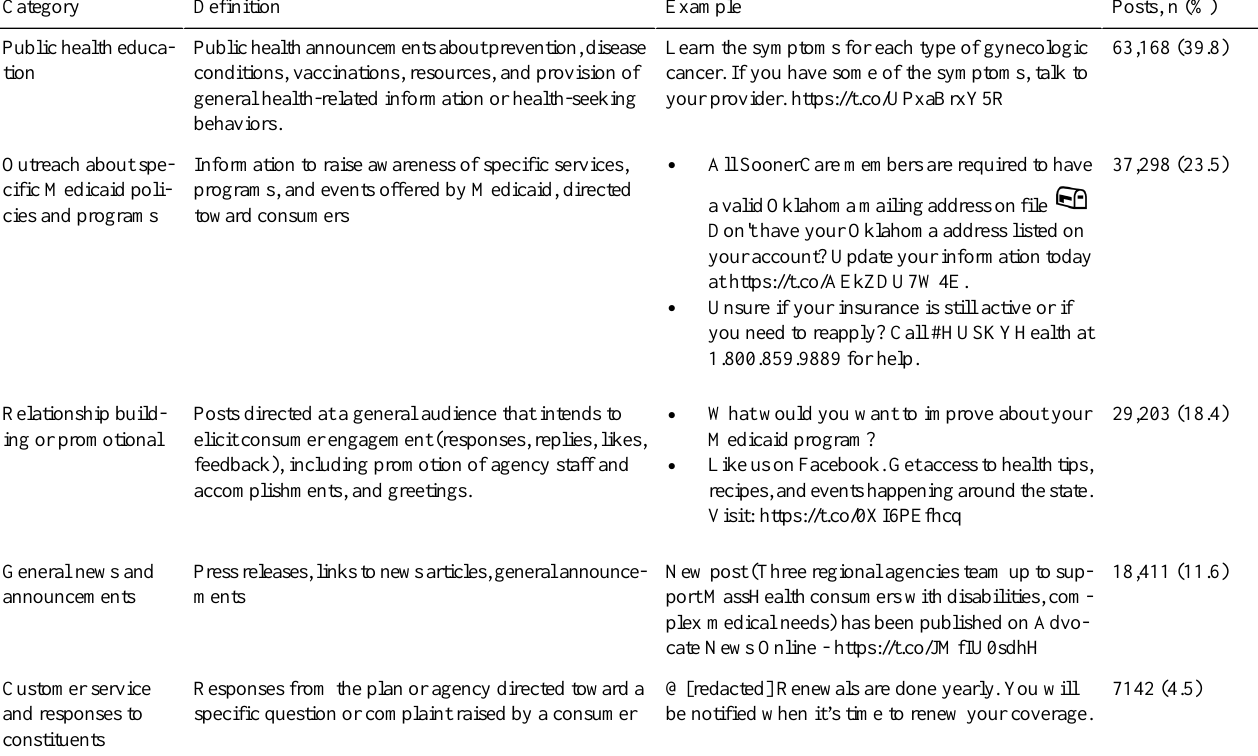
Table 1. Frequency and types of posts from Medicaid agencies and managed care organizations on Twitter (N=158,714) a .